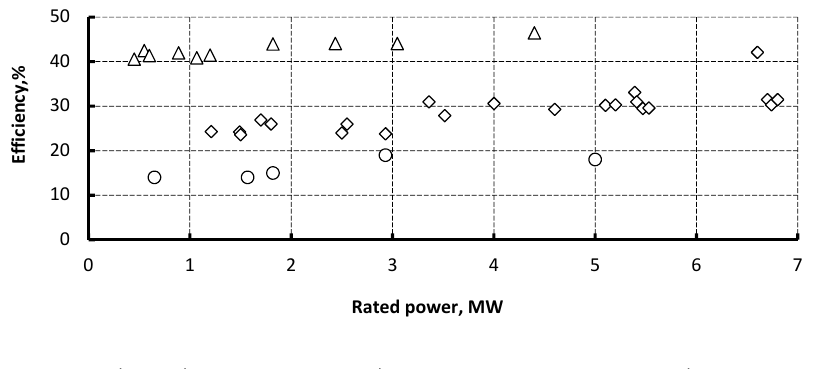
Figure 8. Electric e ffi ciency of gas turbine engines, reciprocating engines, and steam turbine combined heat and power plant CHP (adapted from [56–65]).